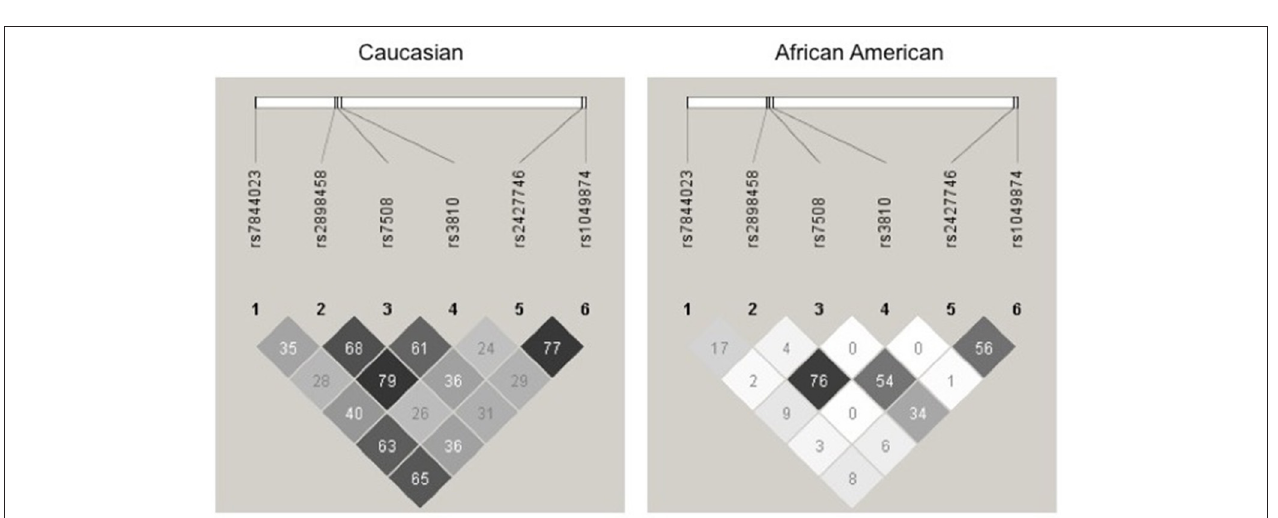
FIGURE 1 | Linkage disequilibrium plot for Acid Ceramidase SNPs . SNPs assessed in the current study are shown above the linkage disequilibrium (LD) plots for genotype in white subjects ( left ) and black subjects ( right ) participating in either STRRIDE I or STRRIDE II. Results given are r 2 -values for association. The intensity of the block is proportional to the association between two variants. SNPs rs2898458, rs7508, and rs3810 as well as rs2427746 and rs1049874 are shown to be in LD( r 2 > 0.6) in whites ( n = 371). Only rs2898458 and rs3810 are in LD ( r 2 > 0.6) in blacks ( n = 114).